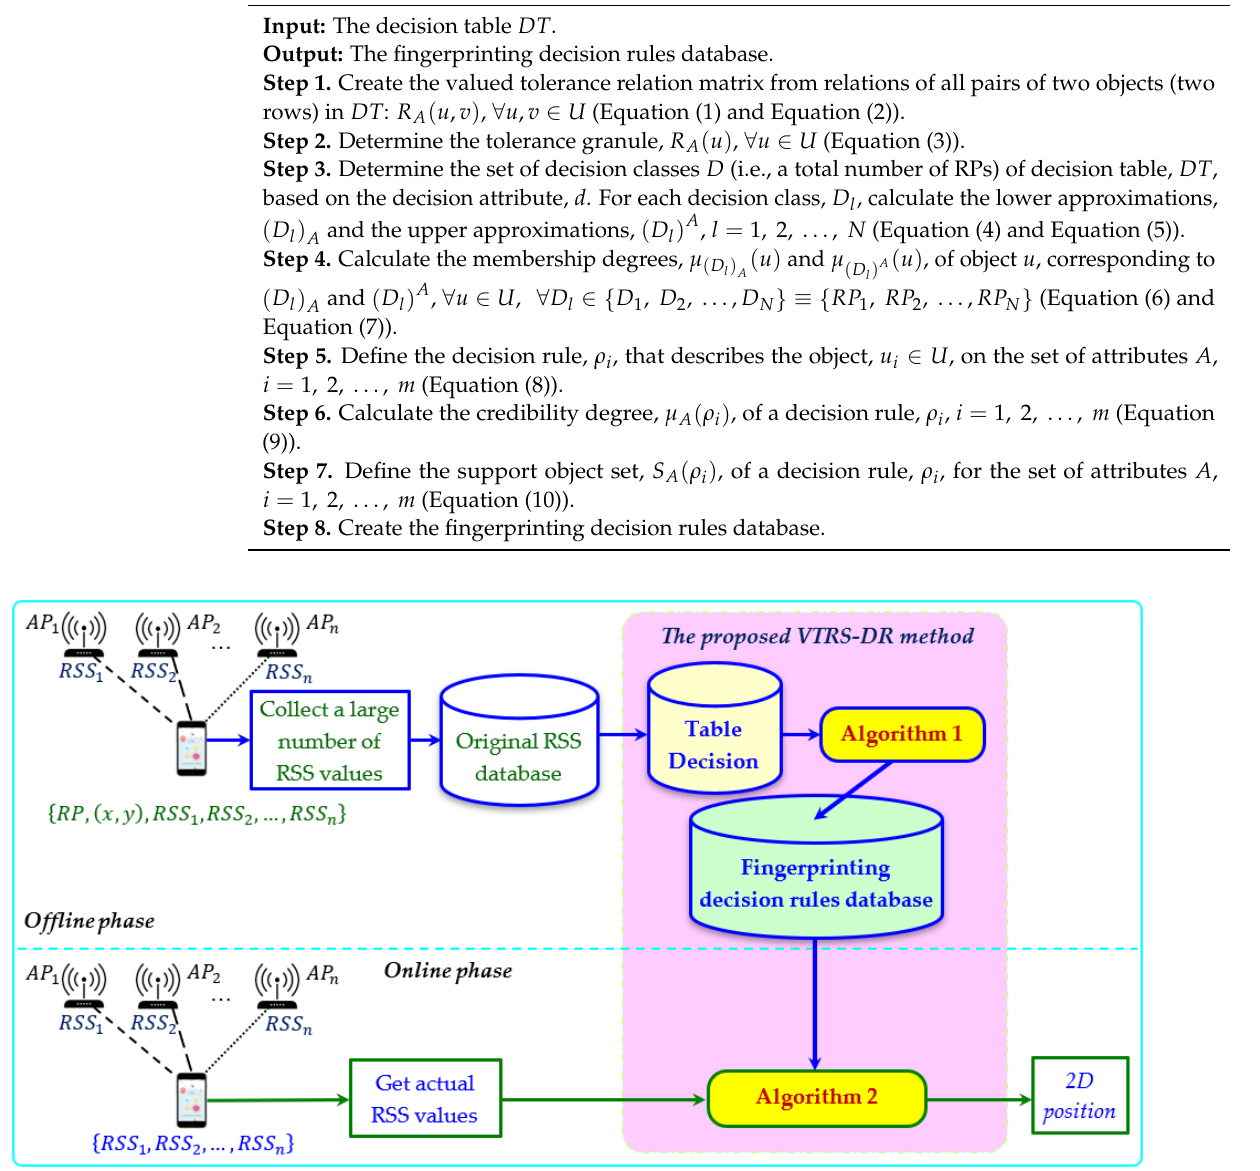
Figure 1. The overall structure of the proposed method. Table 2. The original RSS database.